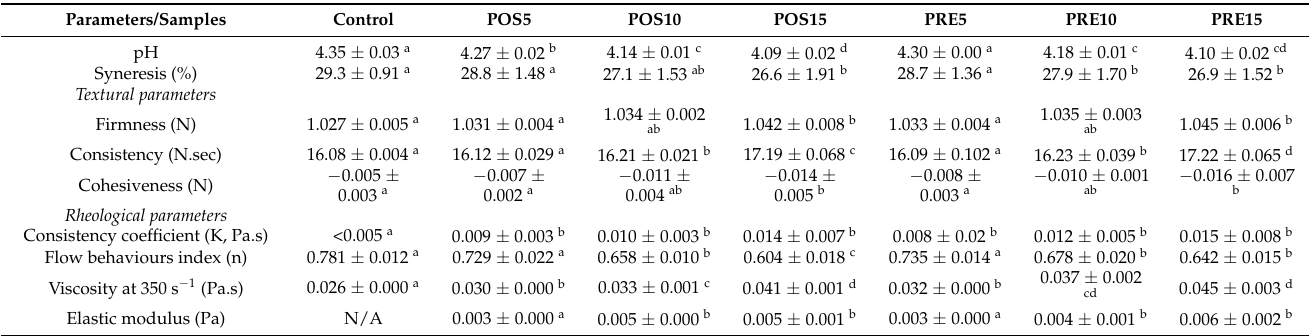
Table 2. Physicochemical properties of yoghurt fortified with CUBTAM (5, 10 and 15%) in PRE and POS. Control yoghurt contained no